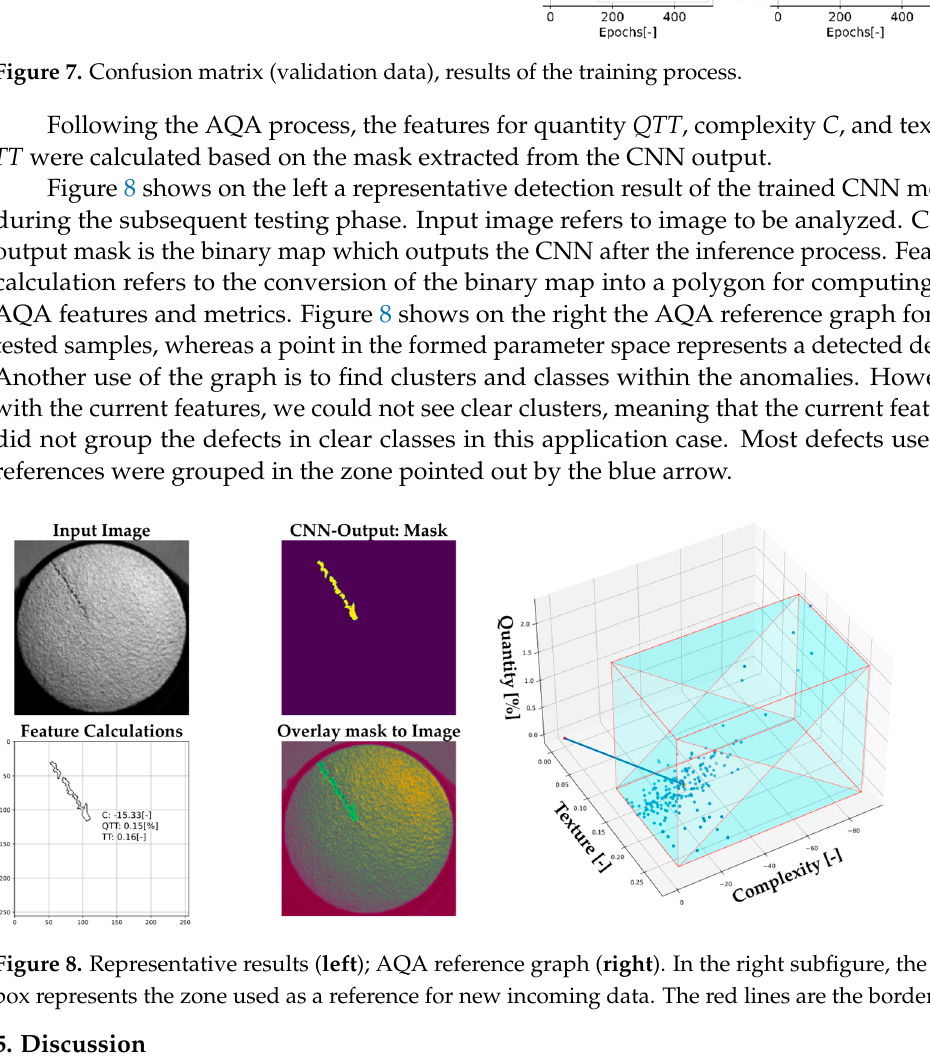
Figure 8. Representative results ( left ); AQA reference graph ( right ). In the right subfigure, the blue box represents the zone used as a reference for new incoming data. The red lines are the borders.